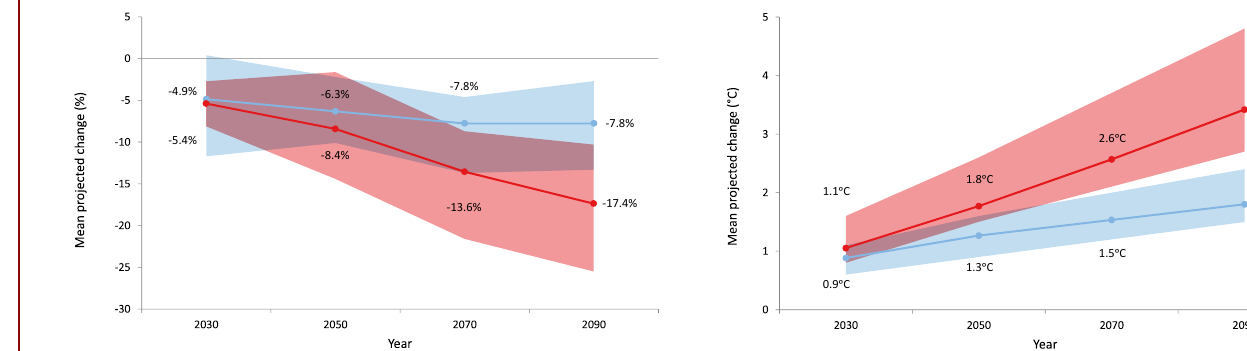
Figure 4. Predicted changes in average annual maximum tempera- ture in the Adelaide Mt. Lofty Ranges region (from Goyder Institute for Water Research,